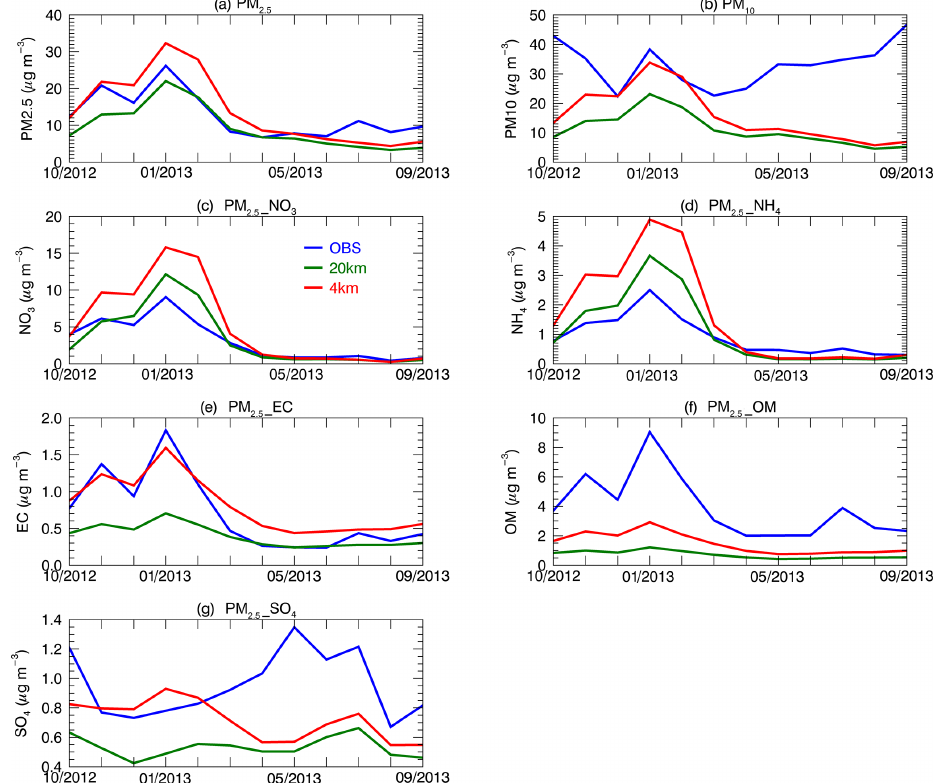
Figure 5. Aerosol mass (µgm − 3 ) for different species from observations and the 20km and 4km simulations at Fresno, CA. NH 4 observations are from the EPA; other observations are from IMPROVE. PM 2 . 5 _NO 3 represents NO 3 with a diameter ≤ 2.5µm. Similar definition for NH 4 , EC, OM and SO 4 in the figures.